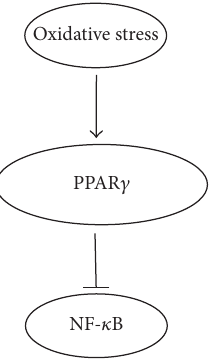
Figure 2: PPAR 𝛾 suppresses the activation of NF- 𝜅 B decreasing its inflammatory